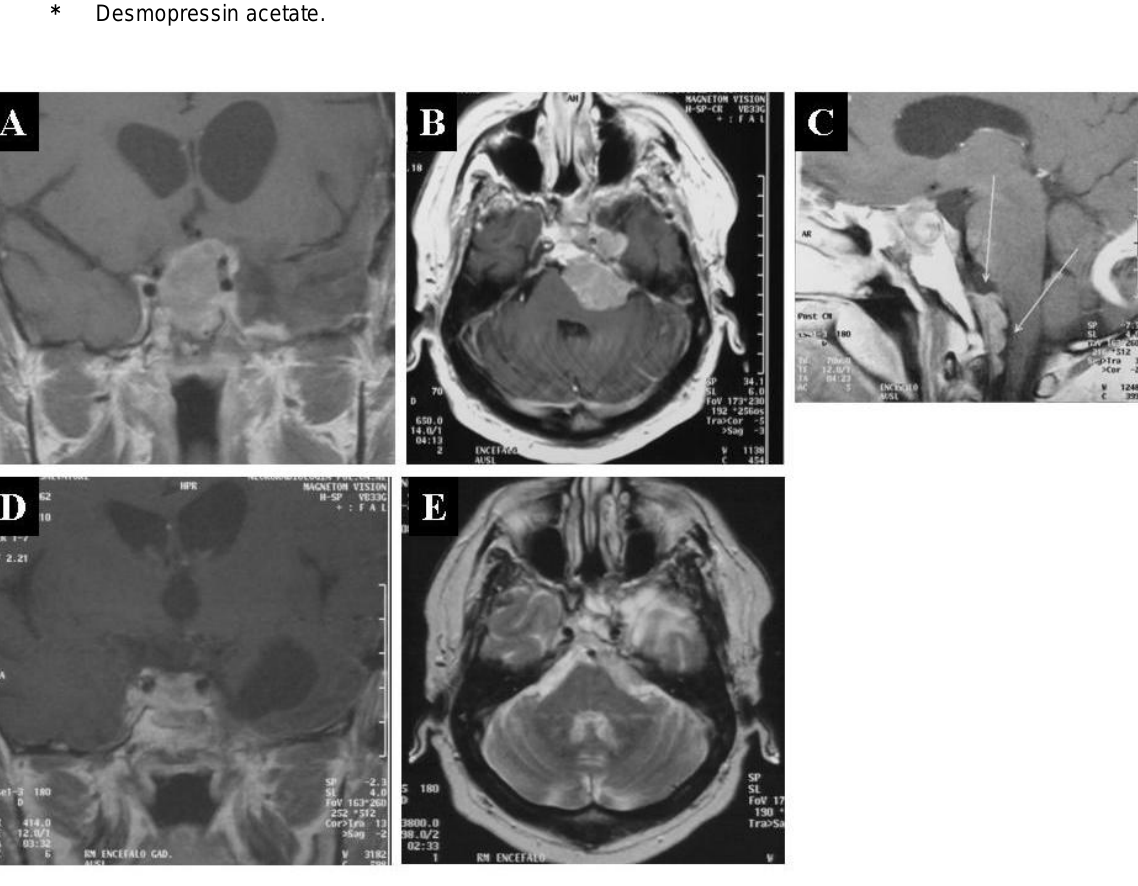
FIGURE 1. MRI evaluation before (A–C) and after (D,E) TMZ treatment. Before TMZ administration, tumor volume, investigated by sagittal, coronal (A), and axial (B) fast spin-echo (FSE) T1-weighted imaging after gadolinium-diethylenetriamine penta-acetate (Gd-DTPA) administration, was 31.1 cm 3 . Sagittal (C) FSE T1-weighted imaging after Gd-DTPA administration demonstrated the presence of an intradural metastasis at the foramen magnum. After four TMZ cycles, tumor volume, investigated by sagittal and coronal (D) FSE T1-weighted imaging and by axial (E) FSE T2-weighted imaging after Gd-DTPA administration, was 2.8 cm 3